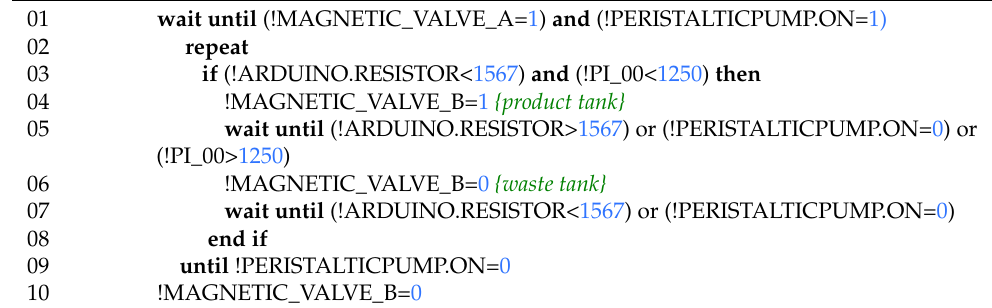
Table A6. HiText™ Rinsing code for “suspension detection” translated from German to English. 01 wait until ( !MAGNETIC VALVE A=1) and (!PERISTALTICPUMP.ON=1) 02